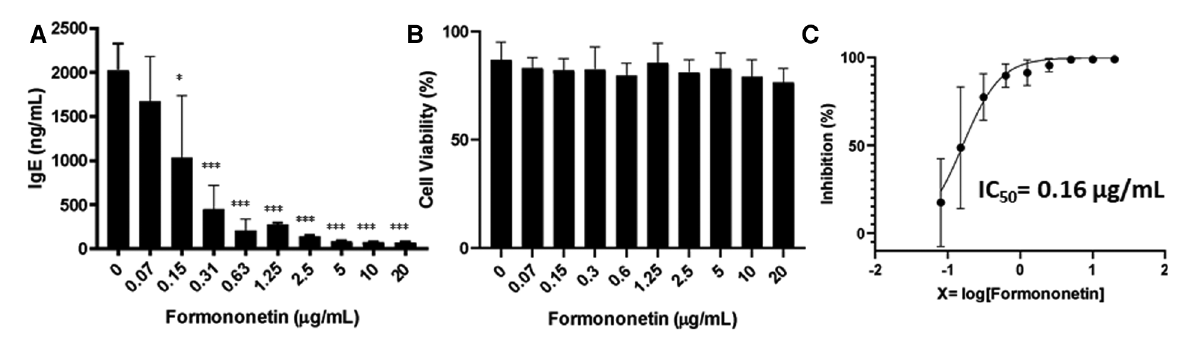
FIGURE 5 Formononetin inhibits IgE production in U266 cells in a dose dependent manner. ( A ) Inhibitory effect of formononetin on IgE production by U266 cells. ( B ) Cell viability of cultured U266 cells with or without formononetin. ( C ) Percentage of IgE inhibition vs. log [formononetin concentration]